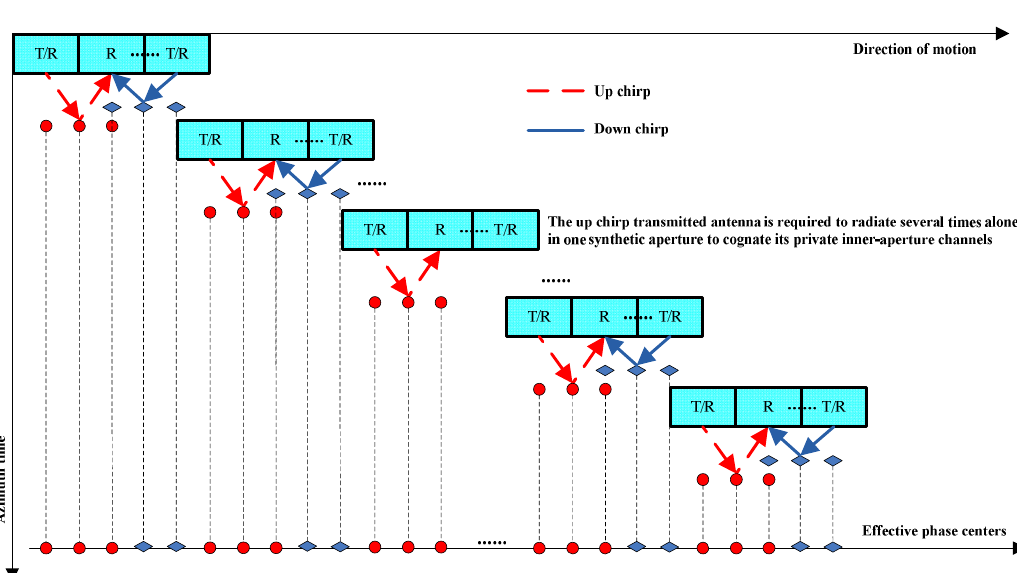
Figure 3. Transmission model of the proposed scheme used for MIMO-SAR system. The up and down chirps are transmitted by the first and the last antennas, respectively. All its antennas are used for receiving echoes. The platform equipped with regularly and compactly spaced antennas is required to move ( 2 N − 1 ) D /2 during one pulse repeat interval (PRI), where N denotes the antenna number, and D denotes the subantenna length. The up chirp transmitted antenna is required to radiate several times alone in one synthetic aperture to cognate its private inner-aperture channels.